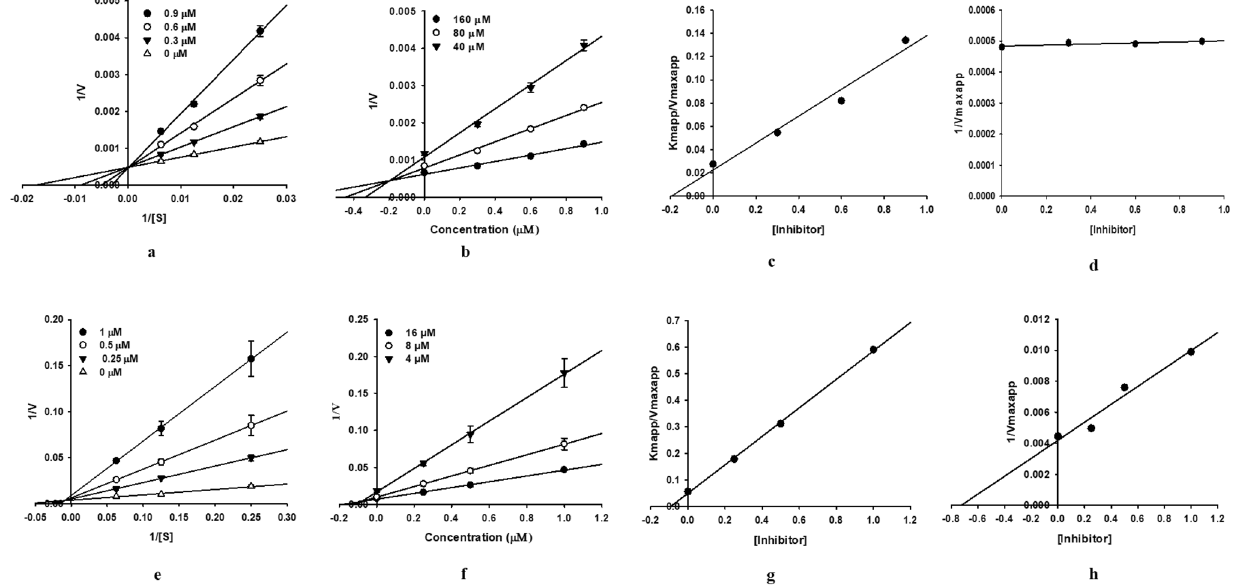
Figure 2. Lineweaver–Burk ( a , e ), Dixon ( b , f ), and secondary plots ( c , d , g , h ) of isoliquiritigenin for the inhibition of hMAO-A and hMAO-B,